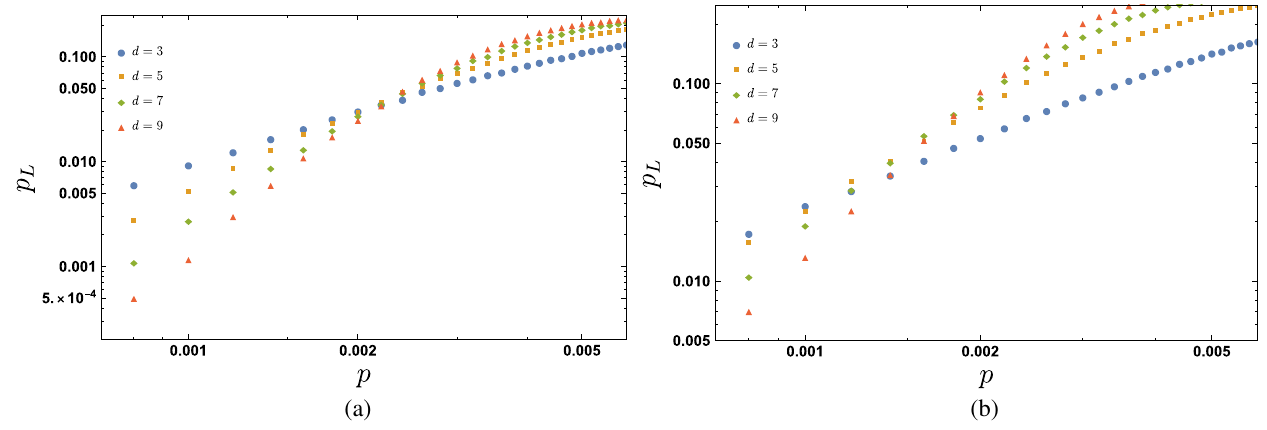
FIG. 18. (a) Logical X -error rates and (b) logical Z -error rates for the heavy-square code when flag-qubit information is ignored. The 0 . 002 , half the value obtained when flag information is used to correct errors. threshold for logical X errors is approximately p th ¼ Further, due to the error propagation properties of the heavy-square code, logical Z -error rates are about an order of magnitude worse compared to those obtained when flag information is